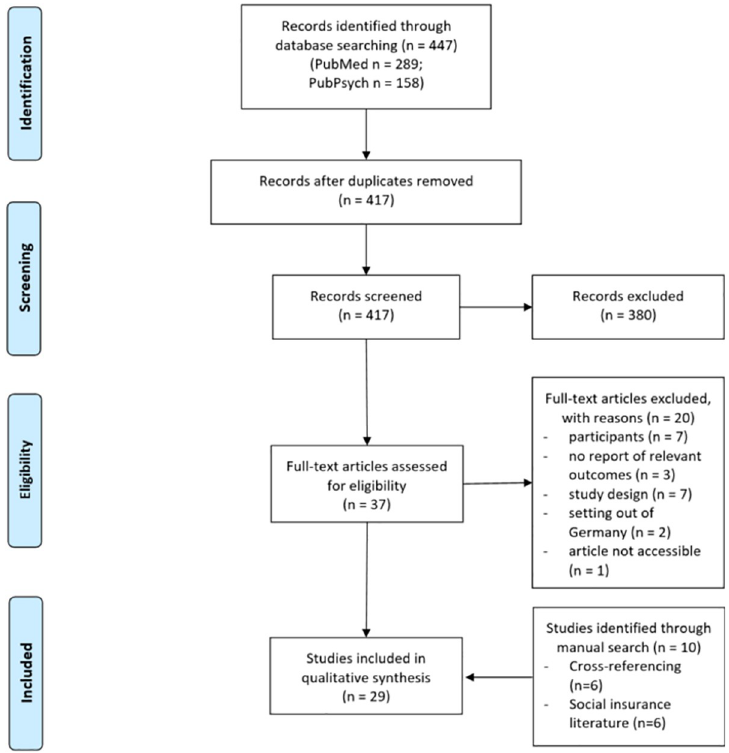
Fig 1. PRISMA flow chart of the systematic literature